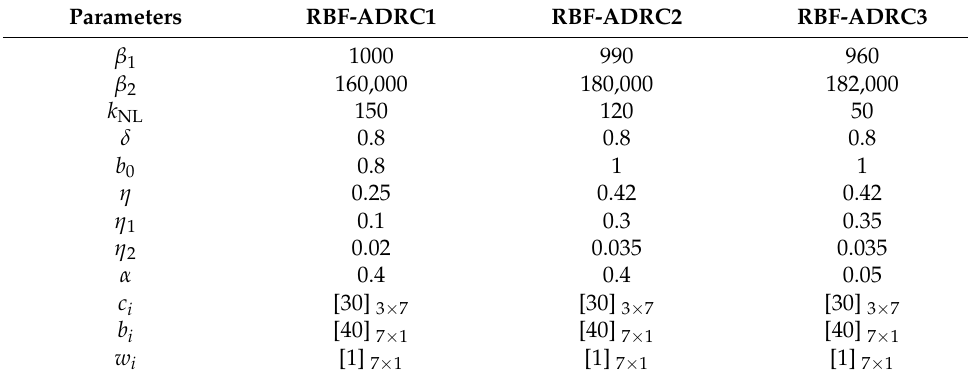
Table 2. Parameters of each RBF-ADRC controller.